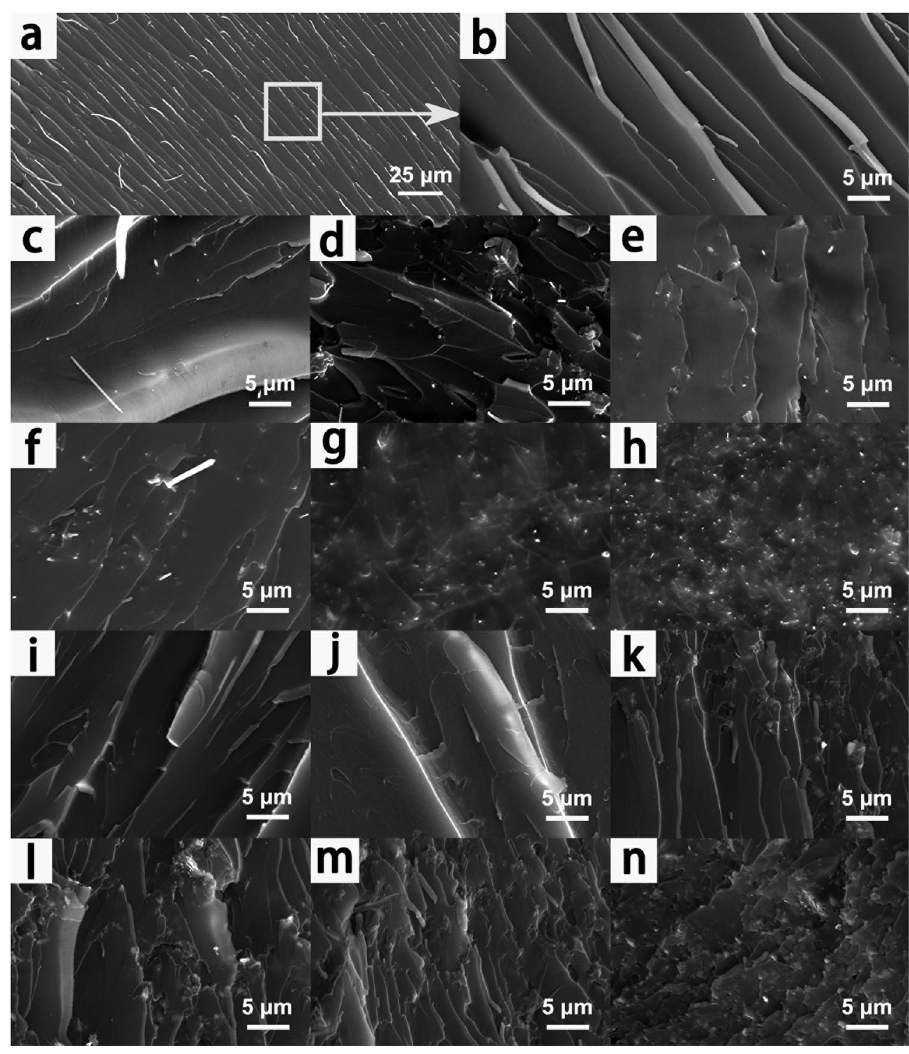
2.0 wt%, ( m ) 2.5 wt%, and ( n ) 3.0